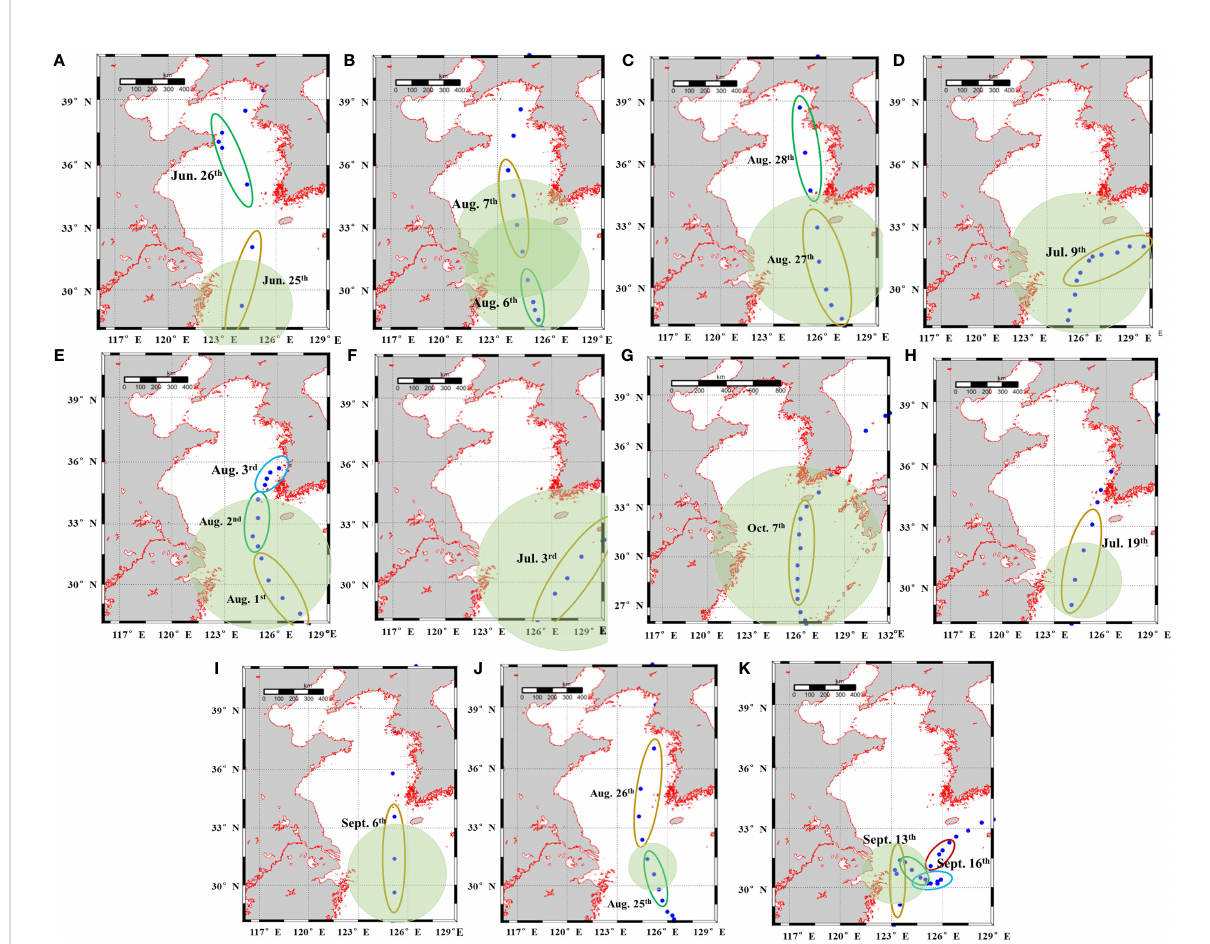
FIGURE 4 The historic track of typhoons. The green circles indicate the in fl uence area of Category 7 wind circle of typhoon (A) 2011 Meari; (B) 2011 Muifa; (C) 2012 Bolaven; (D) 2014 Neoguri; (E) 2014 Nakri; (F) 2017 Talim; (G) 2018 Kong-rey; (H) 2019 Danas; (I) 2019 LingLing; (J) 2020 Bavi; (K) 2021 Chanthu. The trajectory points in colored different ellipses are all within the same day, and the date is indicated next to the